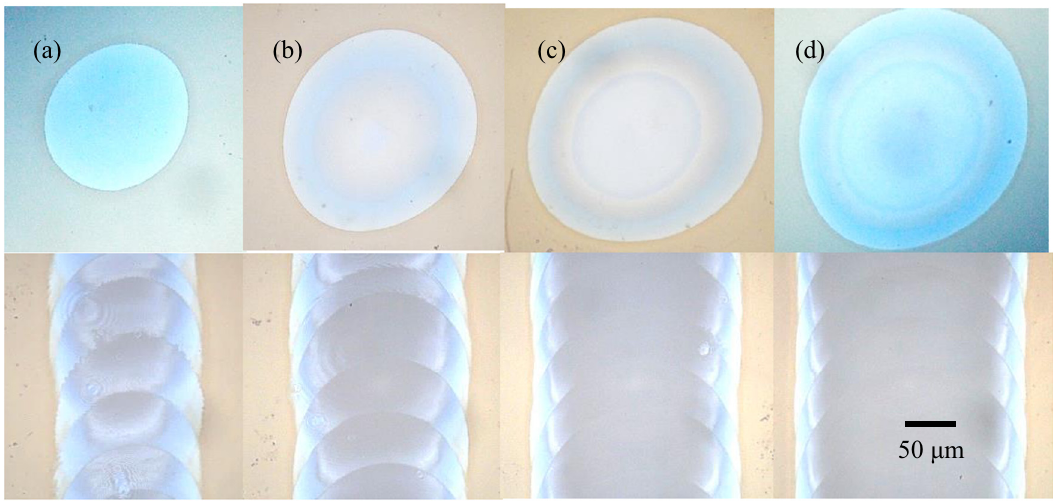
Figure 9: Single fs laser pulse is only able to partially remove the ITO layer on glass ( top ) . Upon multiple laser pulses, some overlapped areas are fully removed ( grey ) at the corresponding laser energies ( bottom ) . ( a ) 190 μ J, ( b ) 250 μ J, ( c ) 400 μ J, ( d ) 620 μ J.